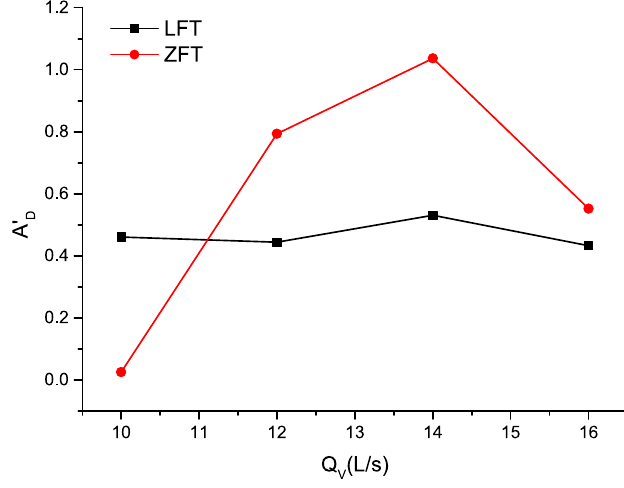
Figure 9. Experimental results of relative pulse amplitude of displacement versus supply flow rate Q V .